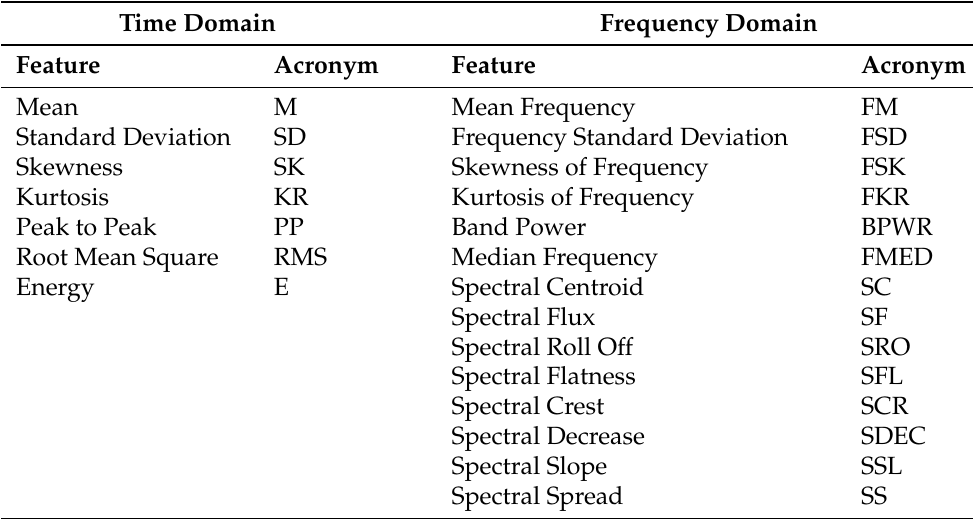
Table 2. List of Features investigated for